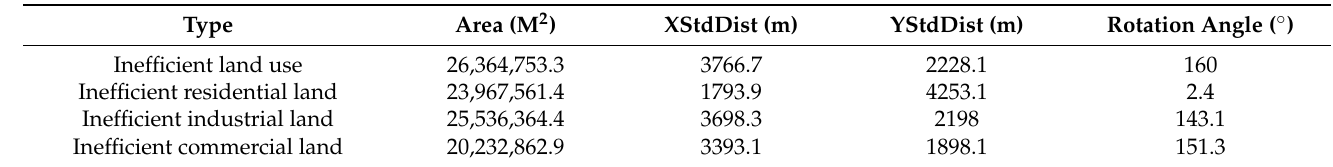
Figure 4. Standard deviation ellipse of the distribution of inefficient land use sites in Xincheng Street. (( a ). Inefficient land; ( b ). Inefficient residential land; ( c ). Inefficient industrial land; ( d ). Inefficient commercial land; ( e ). Overall situation). Table 7. Standard deviation ellipse parameters of the distribution of inefficient land use sites in Xincheng